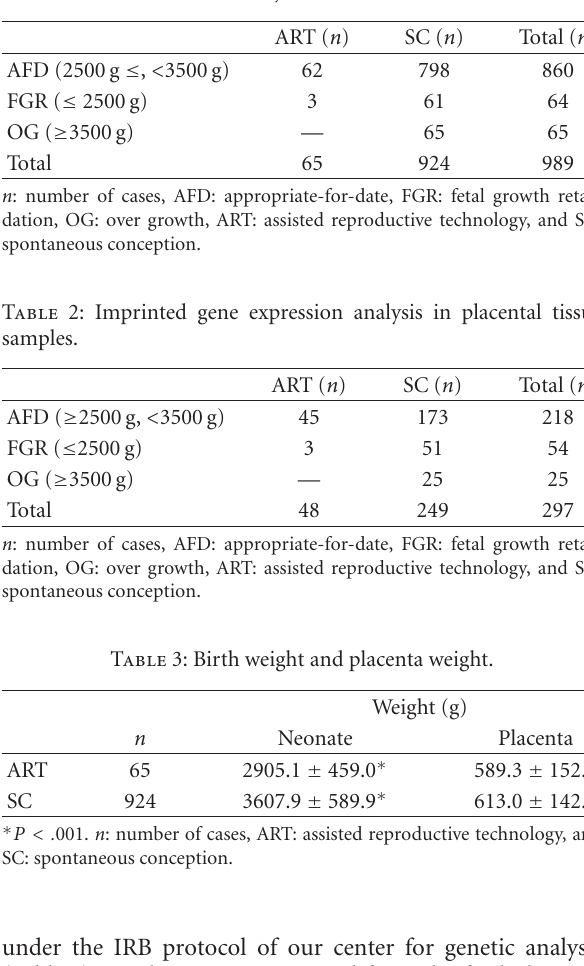
Table 1: Subject characteristics.